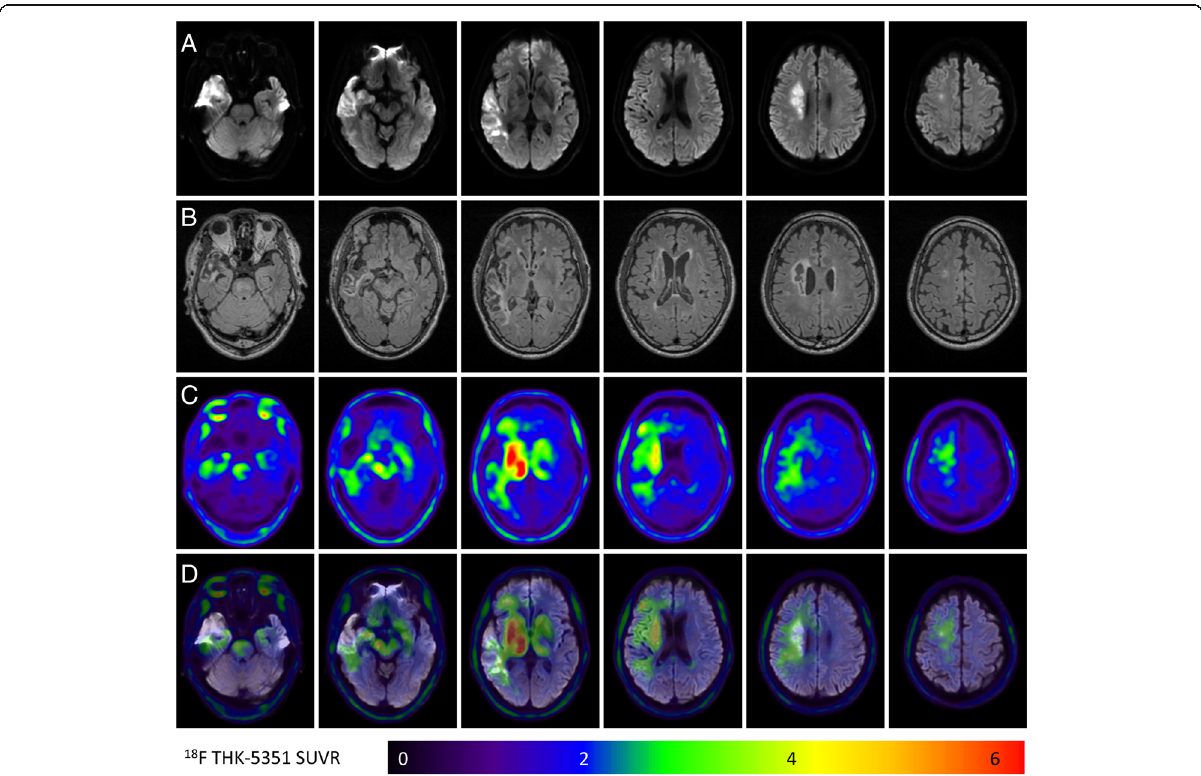
Fig. 1 18 F-THK-5351 retention patterns in an ischemic stroke patient (case 6). a The acute ischemic location on diffusion-weighted imaging (DWI). b , c The FLAIR images and 18 F-THK-5351 PET images taken 3 months after stroke, respectively. d The fused DWI and 18 F-THK-5351 PET images. Common off-target binding of the 18 F-THK-5351 is observed in the bilateral striatum, thalamus, and brainstem. Additionally, the 18 F-THK-5351 retention is asymmetrically increased in the remote and peri-infarct areas and decreased in the infarct